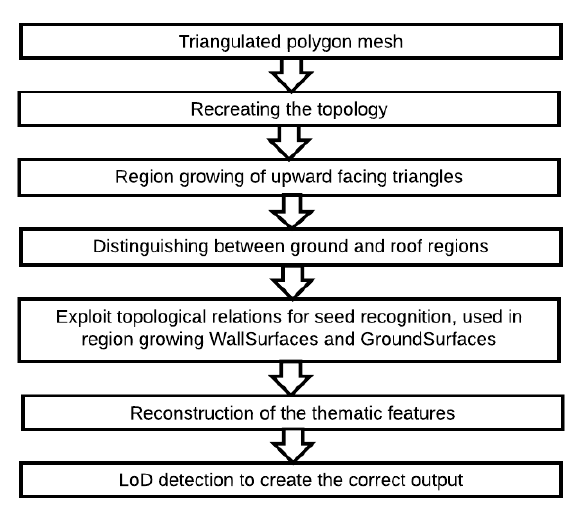
Figure 6: Workflow of the labelling